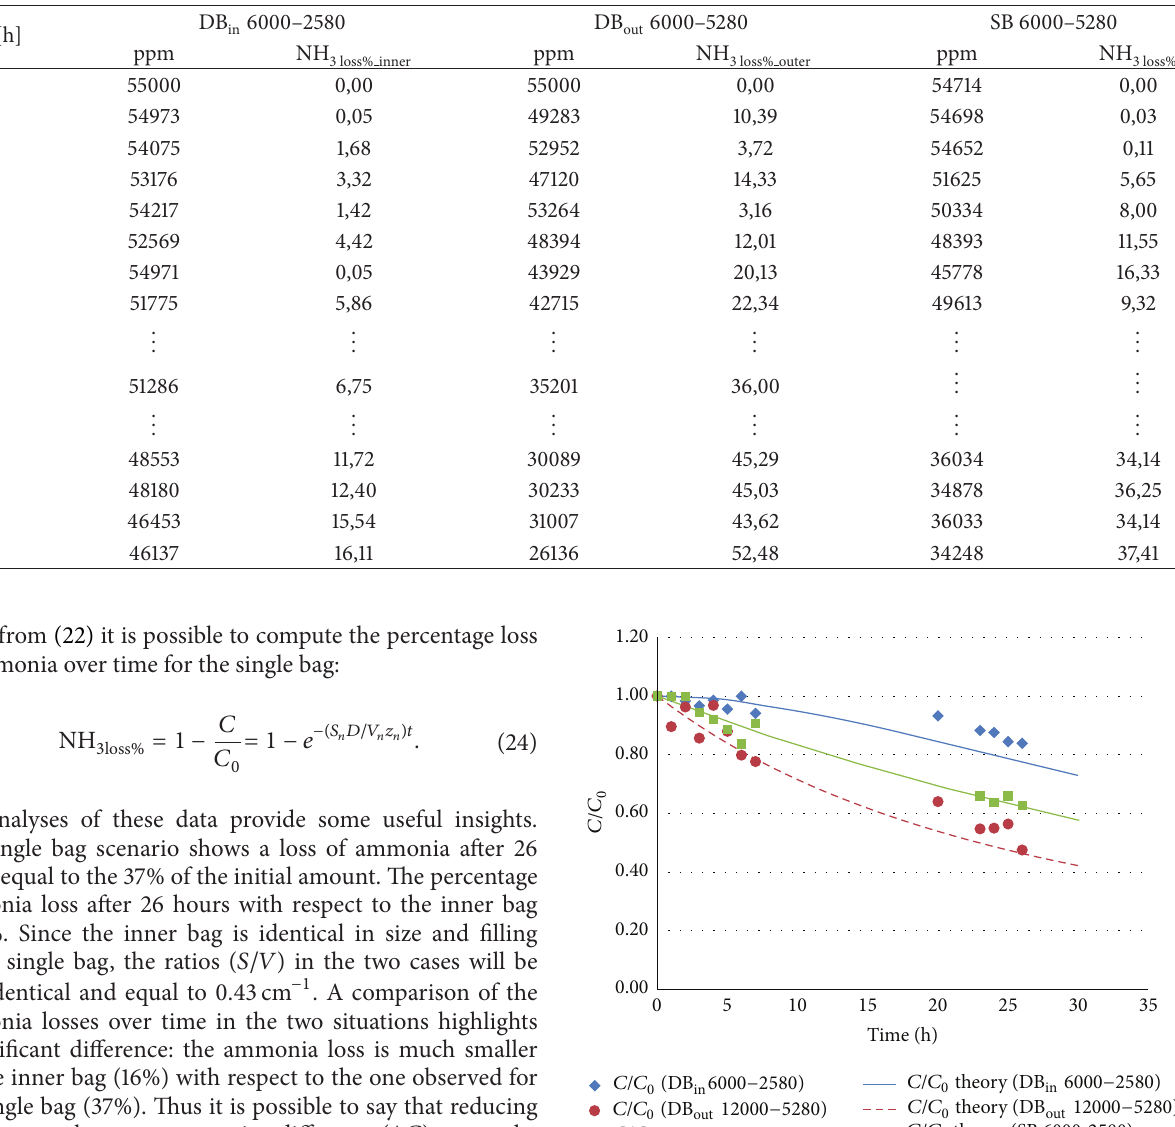
Table 1: Experimental data relevant to NH diffusion over time in Nalophan bags: the inner double bags (DB 3 6000–5280) have 𝑉 𝑛 = 6000 cm 3 and 𝑆 𝑛 = 5280 cm 2 , and the single bag is with 6000 cm 3 and 𝑆 𝑛−1 = 2580 cm 2 , the outer double bags (DB out 𝑉 3 and 𝑆 2 . 𝑛 = 6000 cm 𝑛 = 2580 cm